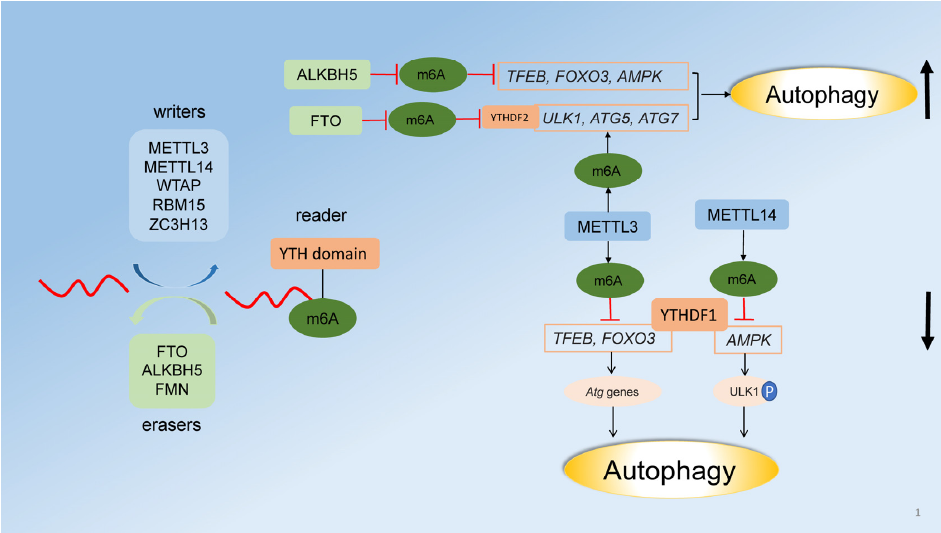
Figure 1. Schematic diagram of m 6 A modification and its regulation of autophagy. m 6 A modification is mediated by the methyltransferases (writers) METTL3, METTL14, WTAP, RBM15, and ZC3H13 and the demethylases (erasers) FTO, FMN, and ALKBH5. m 6 A indirectly affects RNA processing by recruiting reader proteins, which contain the YTH domain [79,80]. FTO upregulates UKL1 , ATG5 , and ATG7 expression to induce autophagy by YTHDF2 ‐ dependent targeting of their mRNA. ALKBH5 demethylates TFEB , FOXO , and AMPK mRNAs to activate autophagy. FOXO , TFEB , and AMPK are the targets of m 6 A reader protein YTHDF1. METTL3 increases m 6 A levels of UKL1 , ATG5 , and ATG7 to upregulate autophagy, whereas METTL3 and METTL14 negatively regulate autophagy through m 6 A methylation of TFEB , FOXO , or AMPK mRNAs, which are responsible for the expression of Atg genes or ULK1 phosphorylation. P indicates